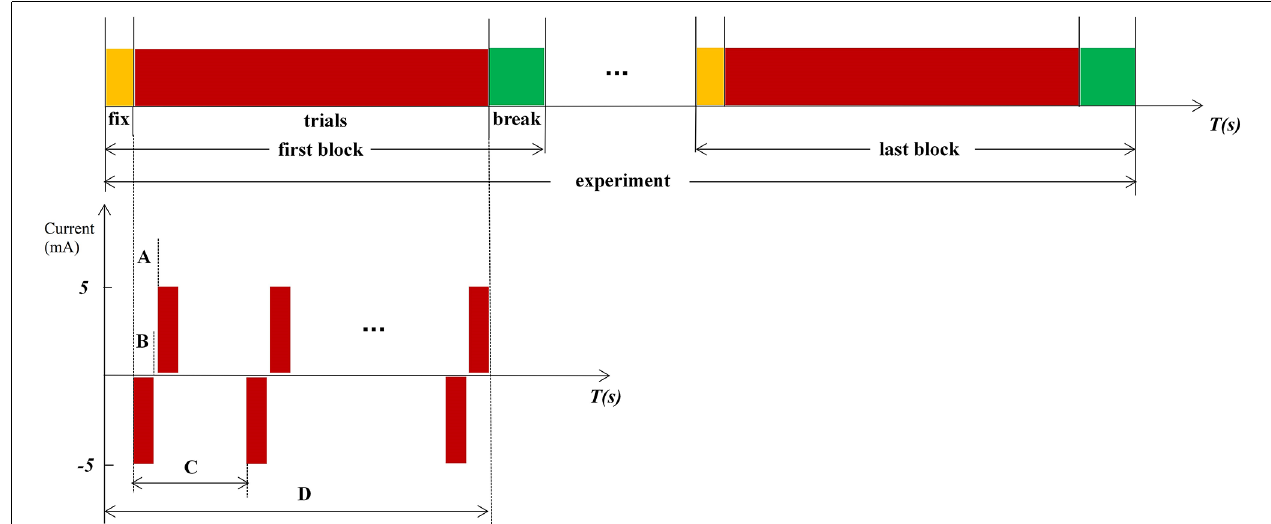
FIGURE 2 | Experimental procedure and paradigm. (A) Internal pulse interval, 220 µ s. (B) Pulse width, 200 µ s. (C) The interval between each set of biphasic, a random value between 8 and12, and the unit is second. (D) Time of 1 fix and 15